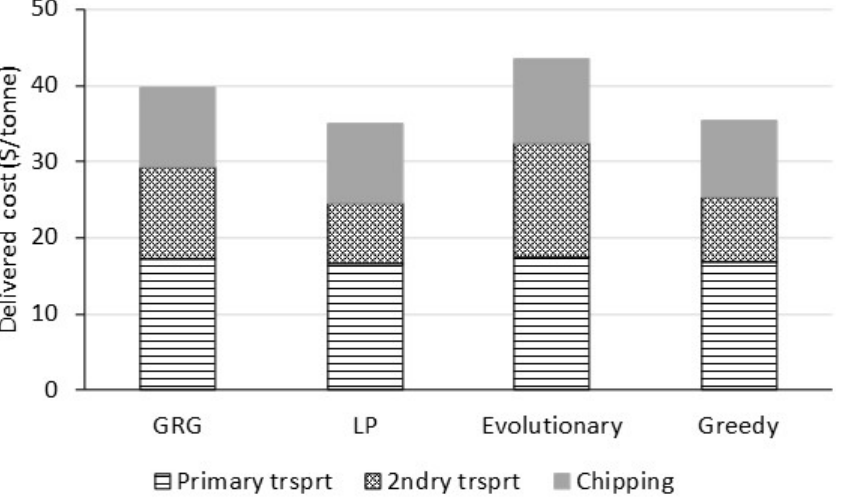
Figure 3. Mean delivered cost (AUD/tonne) for each tested method divided into primary and secondary transport and chipping costs.